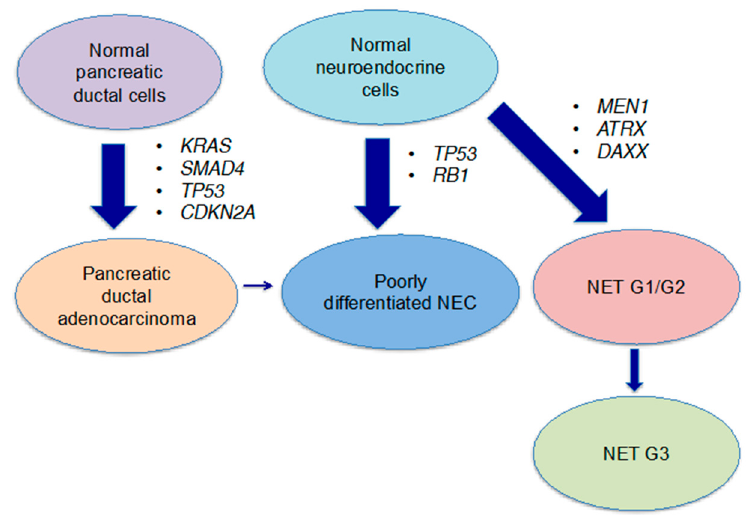
Figure 2. A conceptual diagram of the onset of pNEC. Poorly differentiated NEC is considered to be derived mainly from normal neuroendocrine cells through inactivating mutations of TP53 and RB1 . In addition, some NET G1/G2 cases histologically progress to well-differentiated NET G3, and few cases of NEC are speculated to derive from PDAC cells.